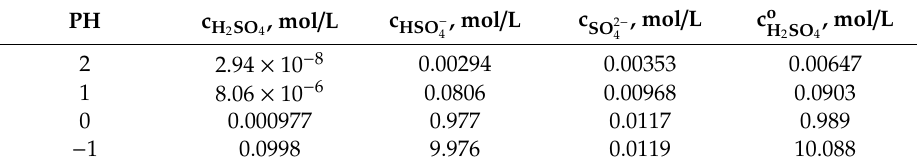
Table A3. Equilibrium concentrations of various aqueous sulphuric acid species and total concentration of sulphuric acid at di ff erent pH values.